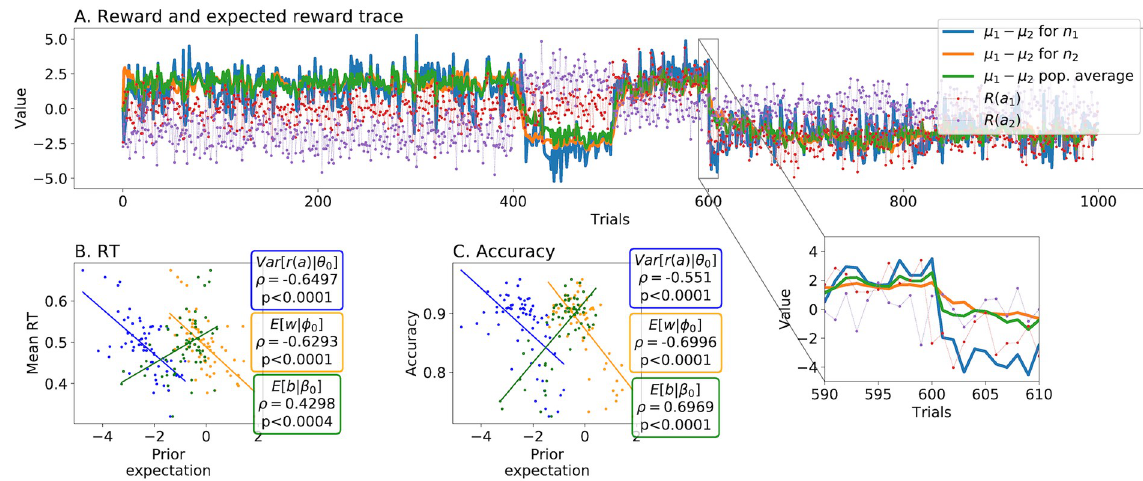
Fig 7. Simulated behavioral results. A . The values of the two available rewards are shown with the dotted lines. The average drift rate μ 1 − μ 2 is shown in plain lines for two selected simulated subjects n 1 and n 2 , and population average. Subject n 1 was more flexible than subject n 2 on both the first and the second level, making her more prone to adapt after the CCs, situated at trials 400, 500 and 600. This result is highlighted in the underlying zoomed box. B . The subjects’ expected variance (blue, log-valued) correlated negatively with the mean RT. The same correlation existed with the expected stability on the first level (orange, logit-valued), but not with the second level, which correlated positively with the average RT (green, logit-valued). Pearson correlation coefficient and respective p-values are shown in rounded boxes. C . Similarly, subjects with a higher expected variance and first-level stability had a lower average accuracy. Again, second-level memory expectation had the opposite